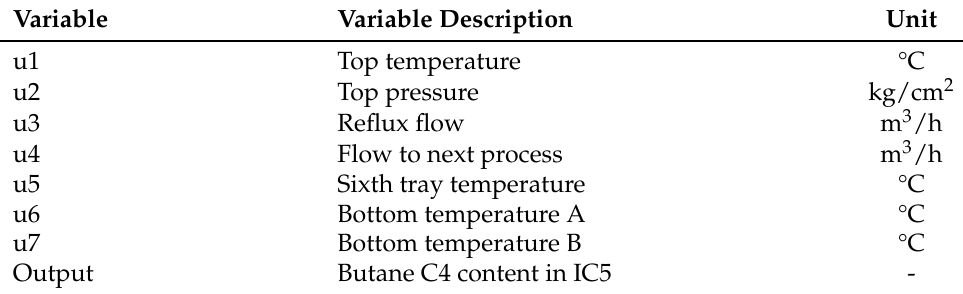
Table 1. Description of debutanizer column process